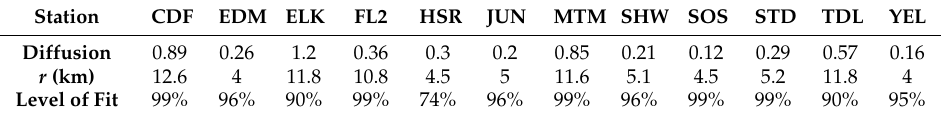
Table 3. Comparison of fit of observed data with estimated theoretical data at 9 Hz.